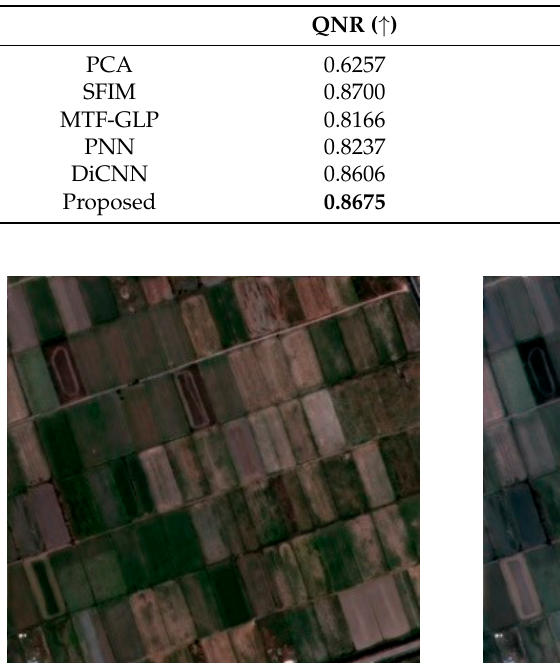
Table 2. Quantitative results of the Quickbird dataset.